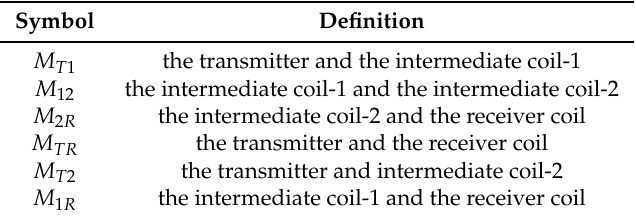
Table 1. Definition of mutual inductance in the equivalent circuit of a two-intermediate coil.